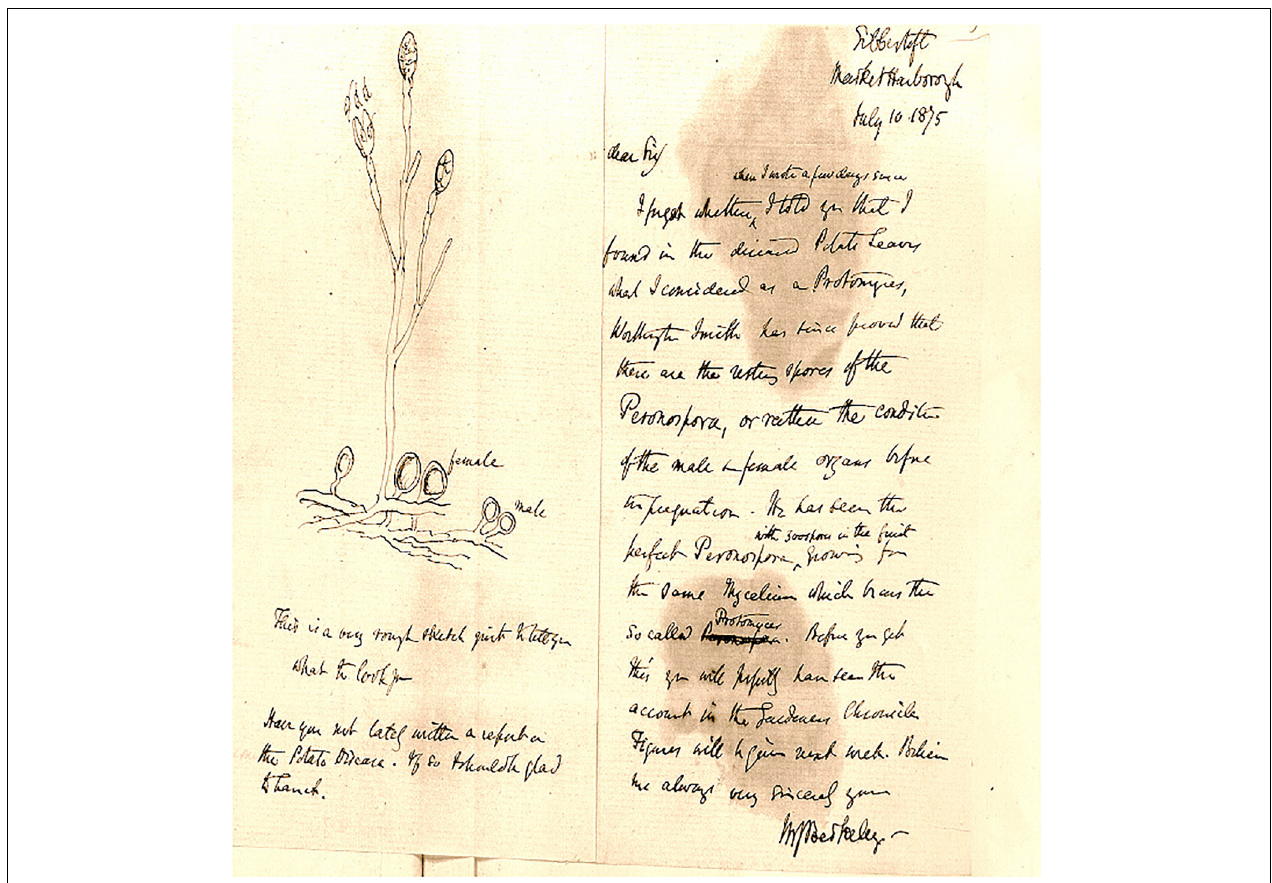
FIGURE 2 | Letter and drawing by Berkeley sent to W. G. Farlow at Harvard University on July 10, 1875 showing the sporangiophore, sporangia, zoospores and putative oogonia (female), and antheridia (male) of P. infestans . Letters deposited in the Farlow Library Archives, Harvard University.